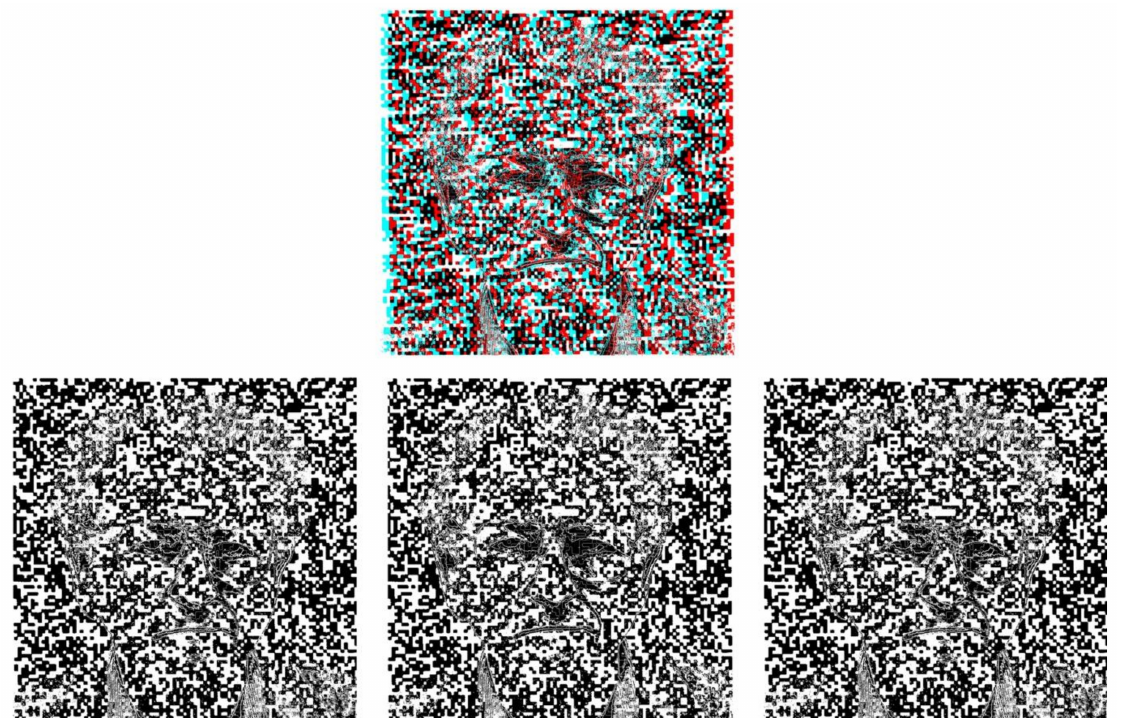
Figure 2. Random-dot stereoscopist . Stereo ‘perceptual portrait’ of Bela Julesz, based on the stereoscopic photograph shown in Figure 1, embedded in a random-dot pattern. Upper: An anaglyph which can be seen in depth with red / cyan glasses. Lower: Left-, right- and left-eye members of the stereoscopic pairs. The modes for proper and pseudoscopic depth viewing are the same as in Figure